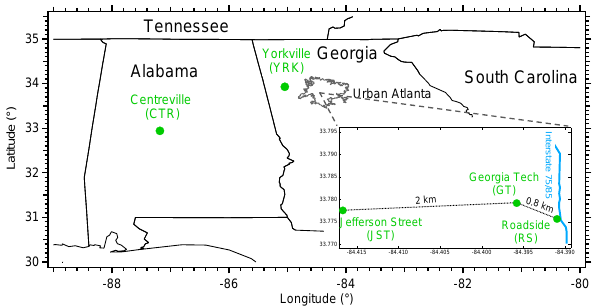
Figure 1. Sampling sites for SCAPE and SOAS studies. The gray circled region represents urban